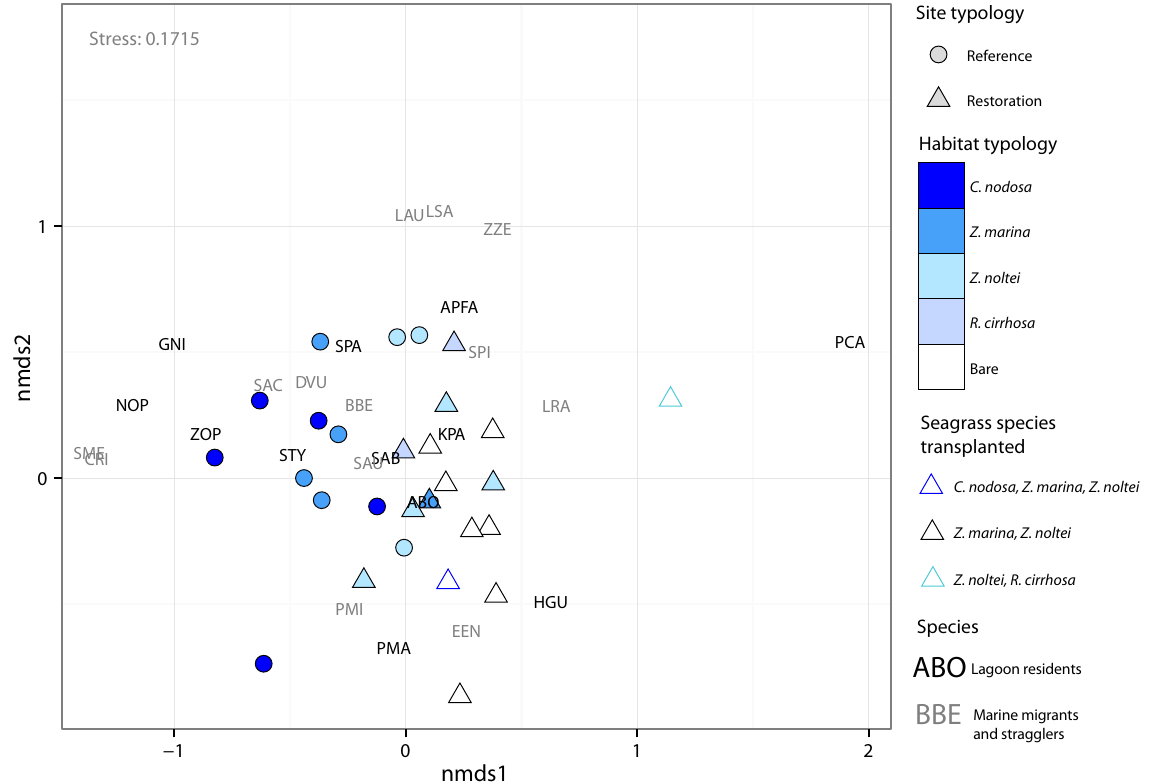
Figure 1. nMDS ordination of fish assemblage at seagrass restoration sites and reference sites. Observations made in each habitat typology (seagrass habitat dominated by C. nodosa , Z. marina , Z. noltei , R. cirrhosa , and bare substratum) and seagrass species used in transplantations are also shown. Fish species (either lagoon residents or marine migrants and stragglers) are labelled as follows: ABO: Atherina